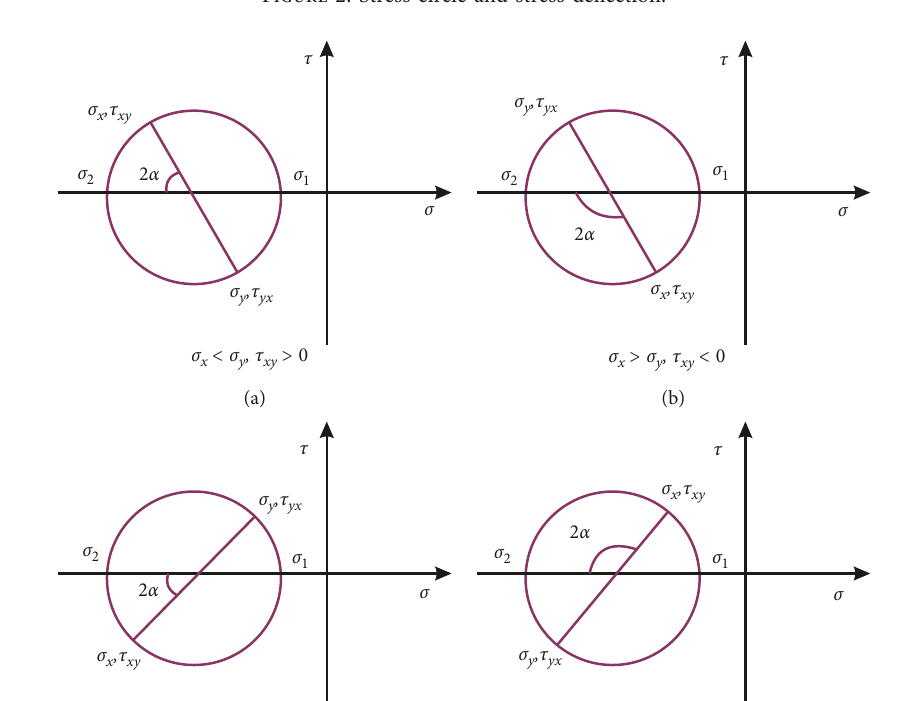
, τ x,y < 0. (c) σ x < σ y